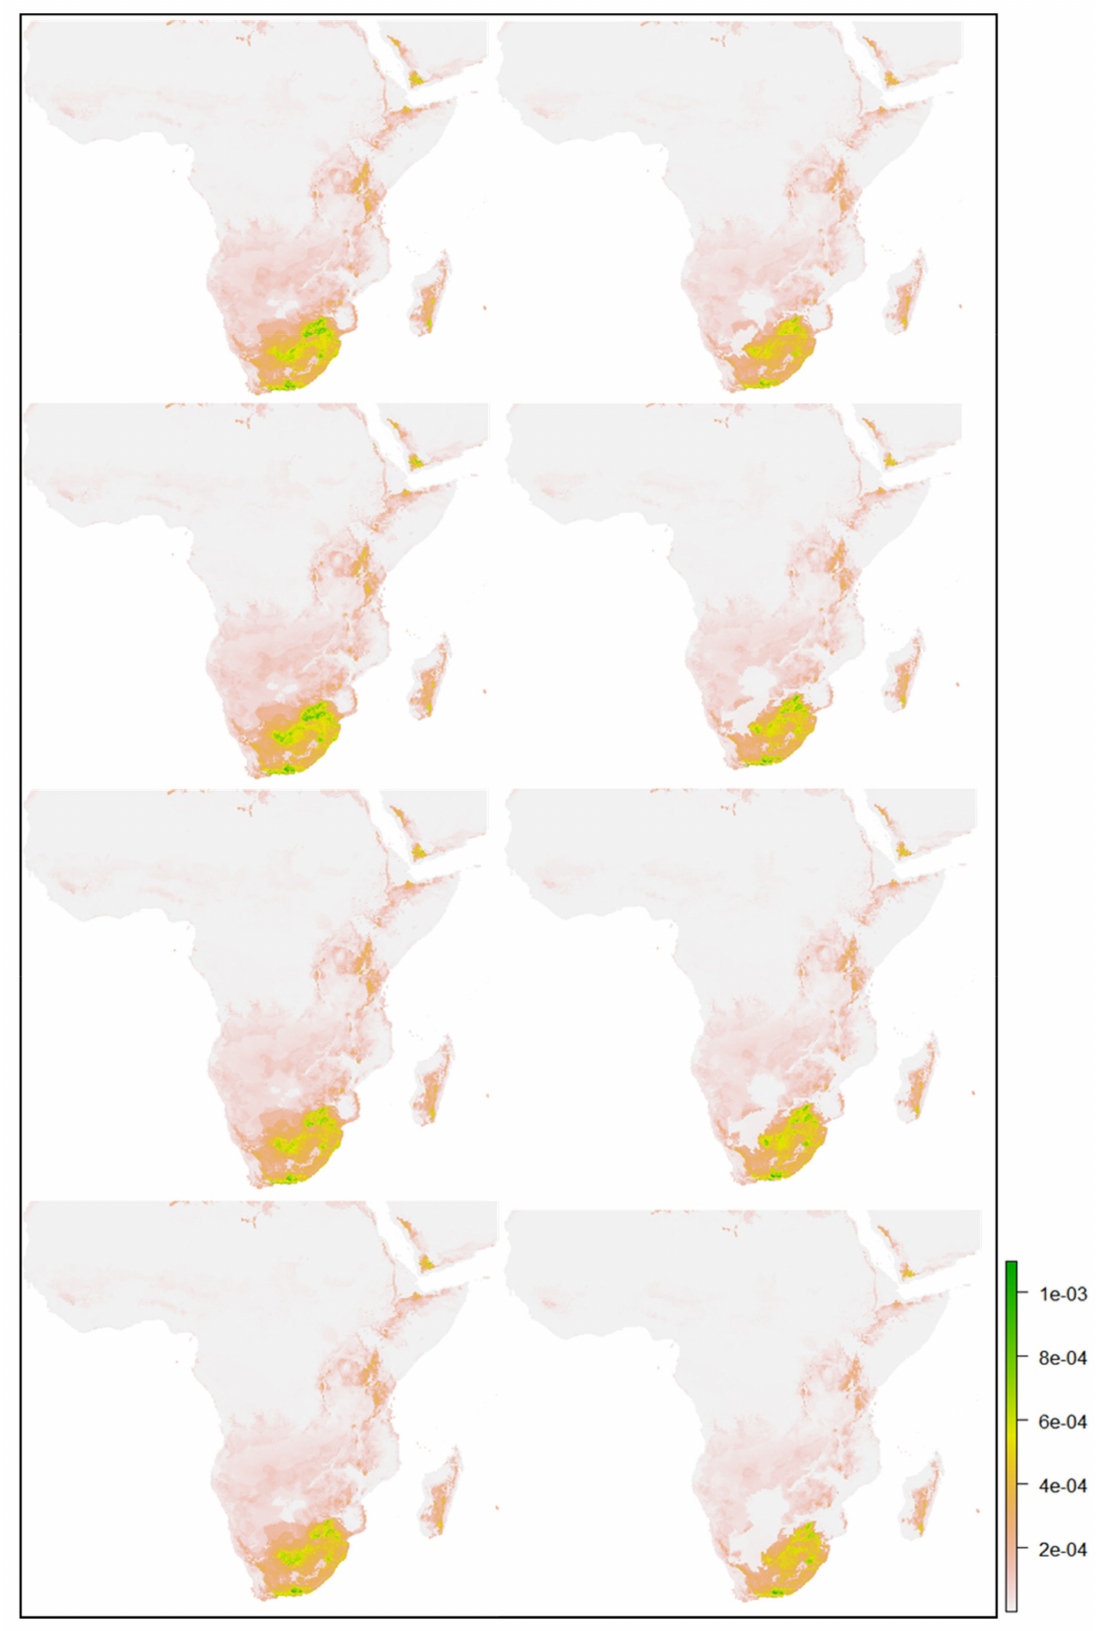
Figure 11. Predicted future suitability maps for Jacobin cuckoos from October to December in Africa: ( a – d ) and ( e – h ) represent the SSPs 2.6, 4.5, 7.0 and 8.5 for 2030 and 2050,